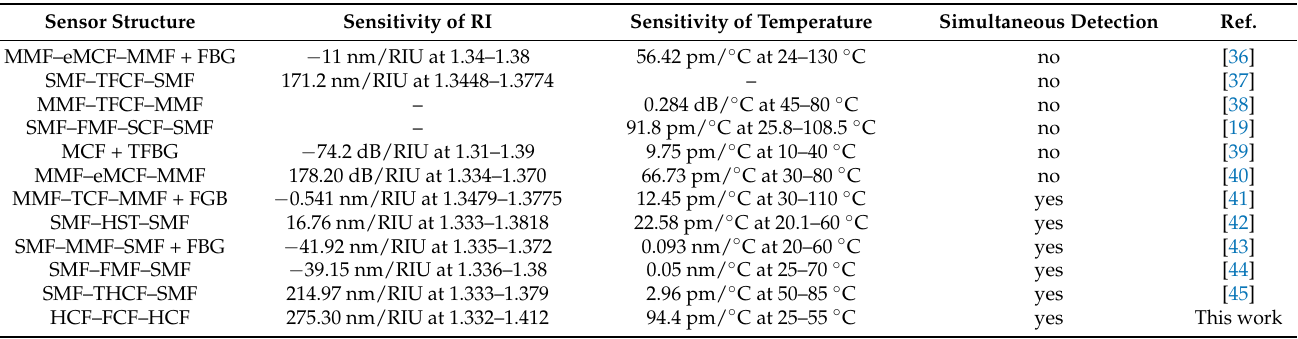
Table 1. Comparison with other MZI sensors of similar structure.